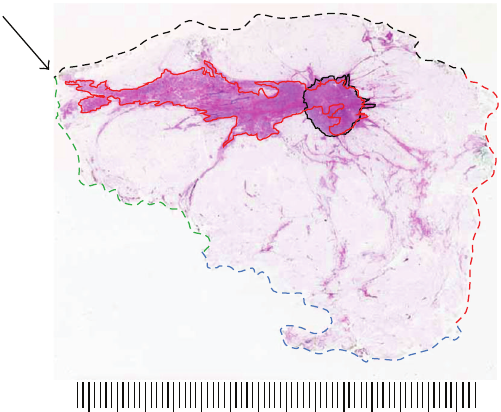
Figure 10: Large-format section of lumpectomy specimen from Figure 9. Analysis of neoplasm size, extent, and margin status. Invasive grade 2 ductal carcinoma is outlined with solid black line, 15mm greatest dimension. Grade 3 DCIS extent outlined with solid red line, 60 mm overall. Circumferential margins marked with broken line. Specimen was sectioned in the sagittal plane to best evaluate critical anterior-superior margin. DCIS extends to within 2mm of intersection of anterior and superior margins (arrow). Scale: small divisions = 1.0 mm (H&E).